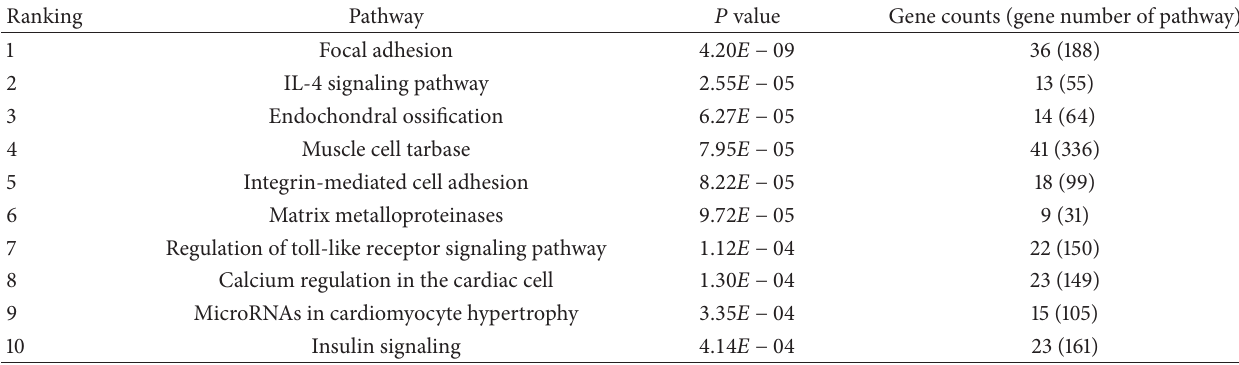
Table 4: The WikiPathways analysis selected gene sets significantly downregulated in MSX1-knockdown cells.